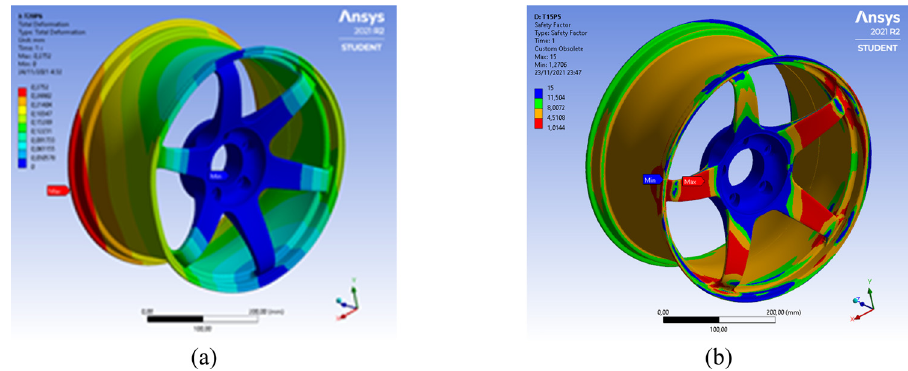
Figure 12: The lowest value of displacement and safety factor: ( a ) SAP6T20 and ( b ) MAP5T15.